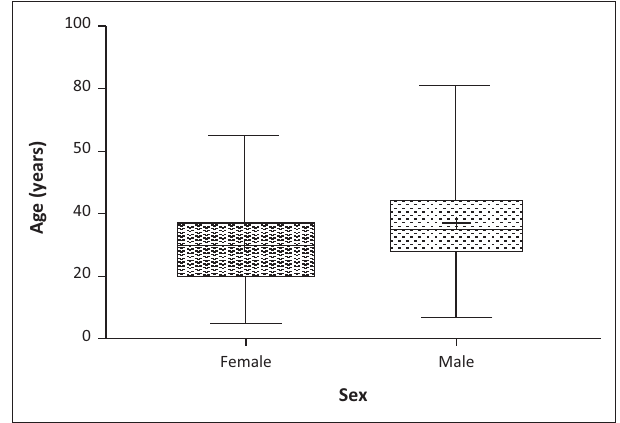
FIGURE 3: Age distribution of suicide decedents amongst males and females.